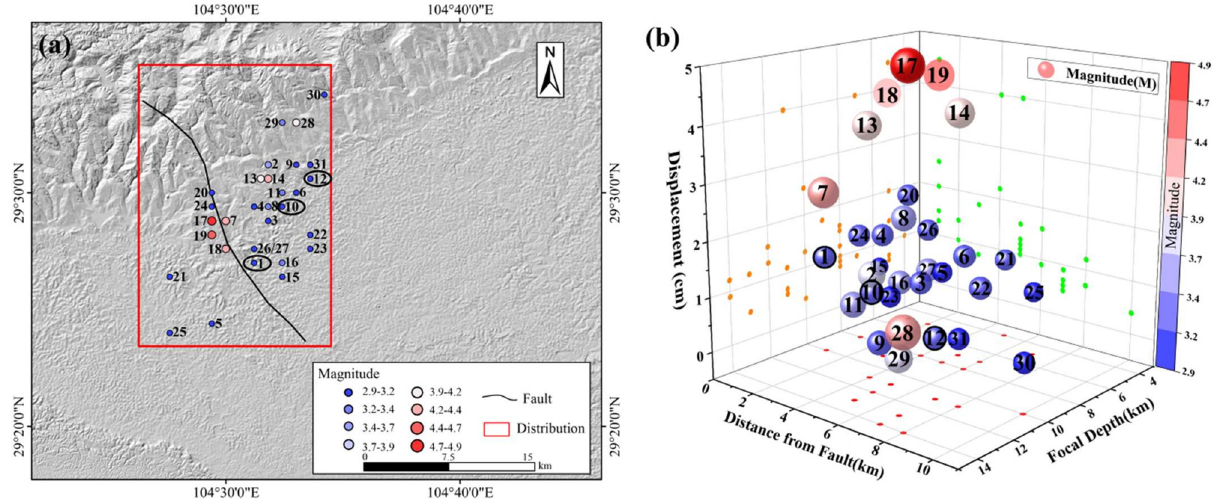
Figure 7. ( a ) Earthquake spatial distribution; ( b ) the correlation between surface displacements, earthquake magnitude, focal depth and distance from